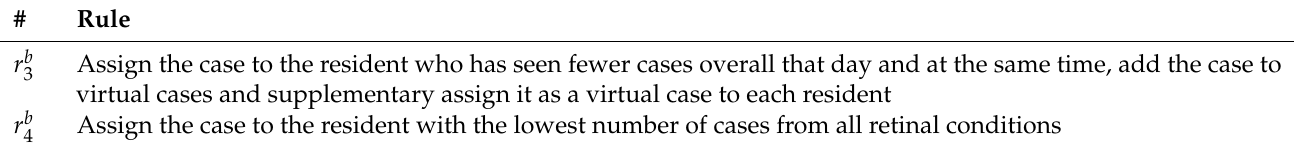
Table 8. Assignment rules for real cases with a diagnosis not contained in the 19 RCs.